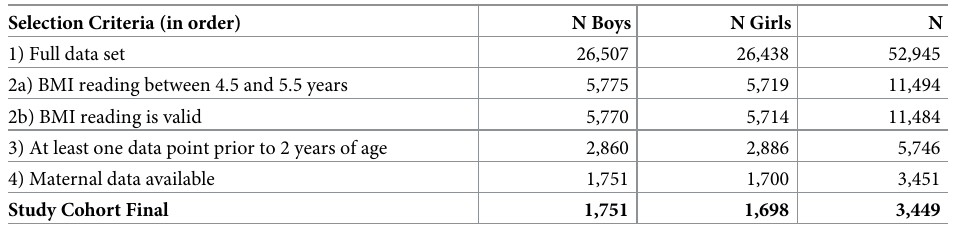
Table 1. Number of children included at each selection